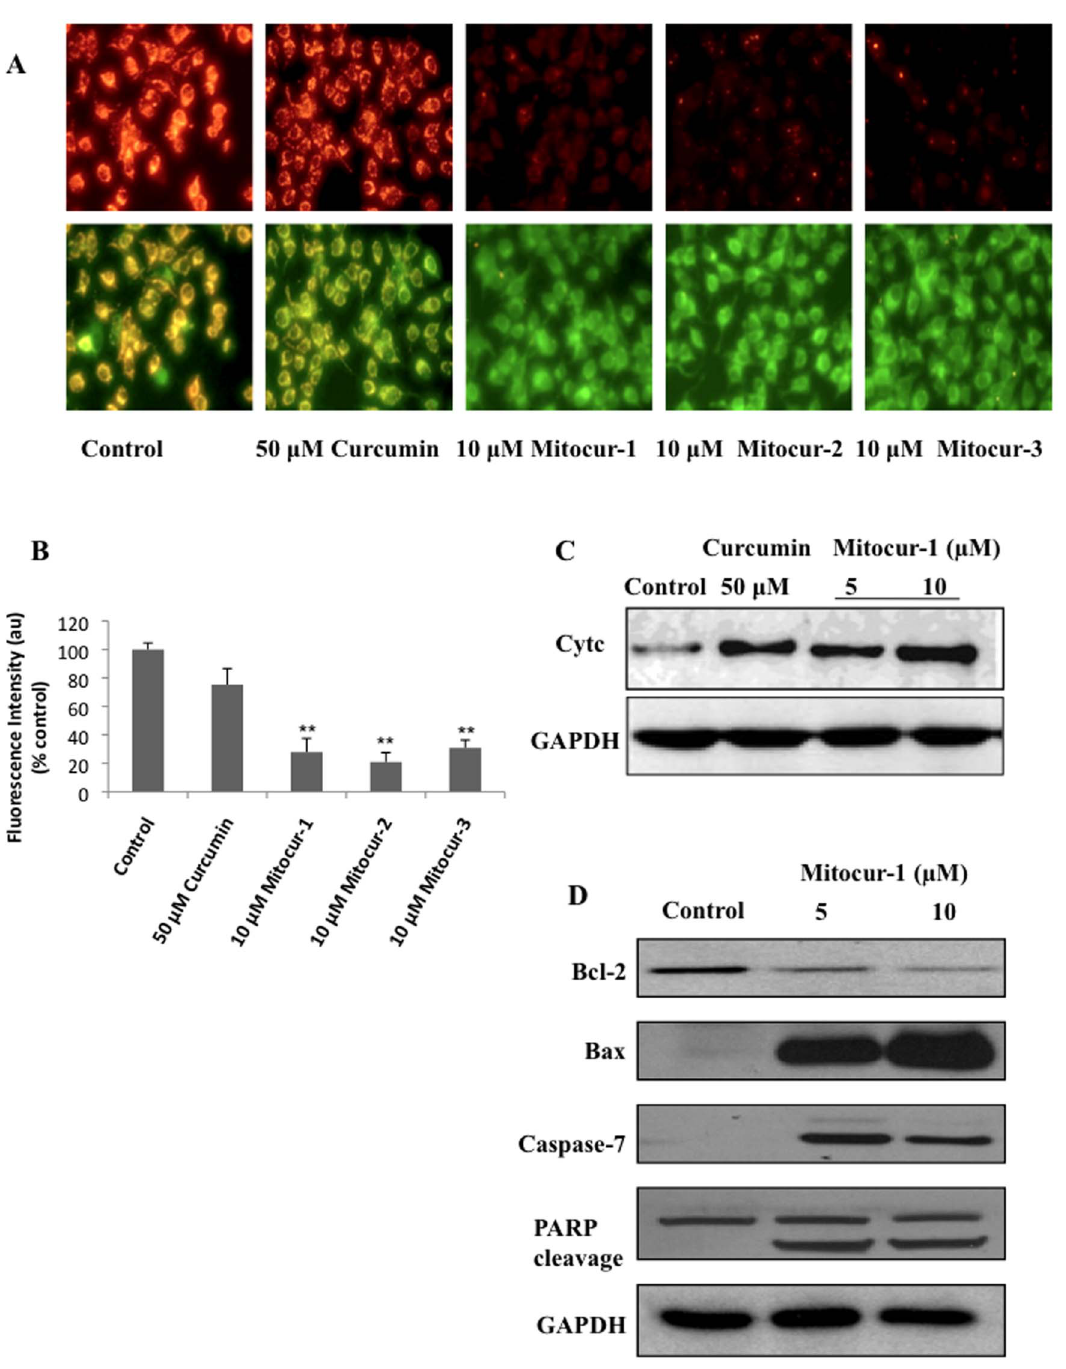
Figure 4. Effect of mitocurcuminoids and curcumin on mitochondrial membrane potential and apoptotic markers. ( A ) Cells were treated with 10 m M Mitocur-1, 2, 3 or 50 m M curcumin for 4 h. Then washed with PBS and incubated with JC-1 dye (5 m g/ml) for 20 min to measure the loss of mitochondrial membrane potential. Fluorescence images were captured in both FITC and rhodamine filters and images showing J- aggregates are represented. ( B ) shows quantification of images (J-aggregates) shown in A. ( C ) Mitochondria and cytosolic fractions were isolated using ProteoExtract Cytosol/Mitochondria Fractionation Kit and cytochrome c levels were measured by Western blot analysis. ( D ) MCF-7 cells were treated with Mitocur-1 (5 and 10 m M) for 24 h. Total protein was resolved by SDS-PAGE electrophoresis and Western blot analysis was performed using respective antibodies for Bcl2, Bax, caspase-7 and PARP. **, significantly different compared to control (p , 0.01). doi:10.1371/journal.pone.0089351.g004 Compared to baseline expression of BNIP3 in MCF-7 cells, Mitocur-1 regulates BNIP3 expression possibly via treatment of Mitocur-1, showed a significant increase in the altering DNMT BNIP3 expression (Fig. 7A). To study the role of DNA methylation Mitocur-1 at sub-micromolar concentrations (5–10 m M) in- and histone deacetylation on BNIP3 expression, specific inhibitors duced BNIP3 expression in MCF-7 cells treated for 24 h.